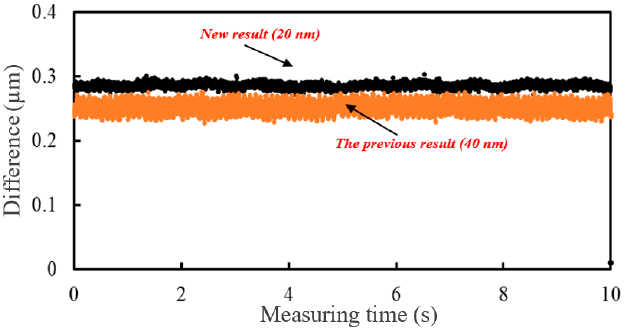
Figure 8. Displacement-measuring result: ( a ) the displacement-measuring result using the interferometer (black line) and the capacitive sensor (red line); ( b ) the displacement difference between the interferometer and the capacitive sensor.